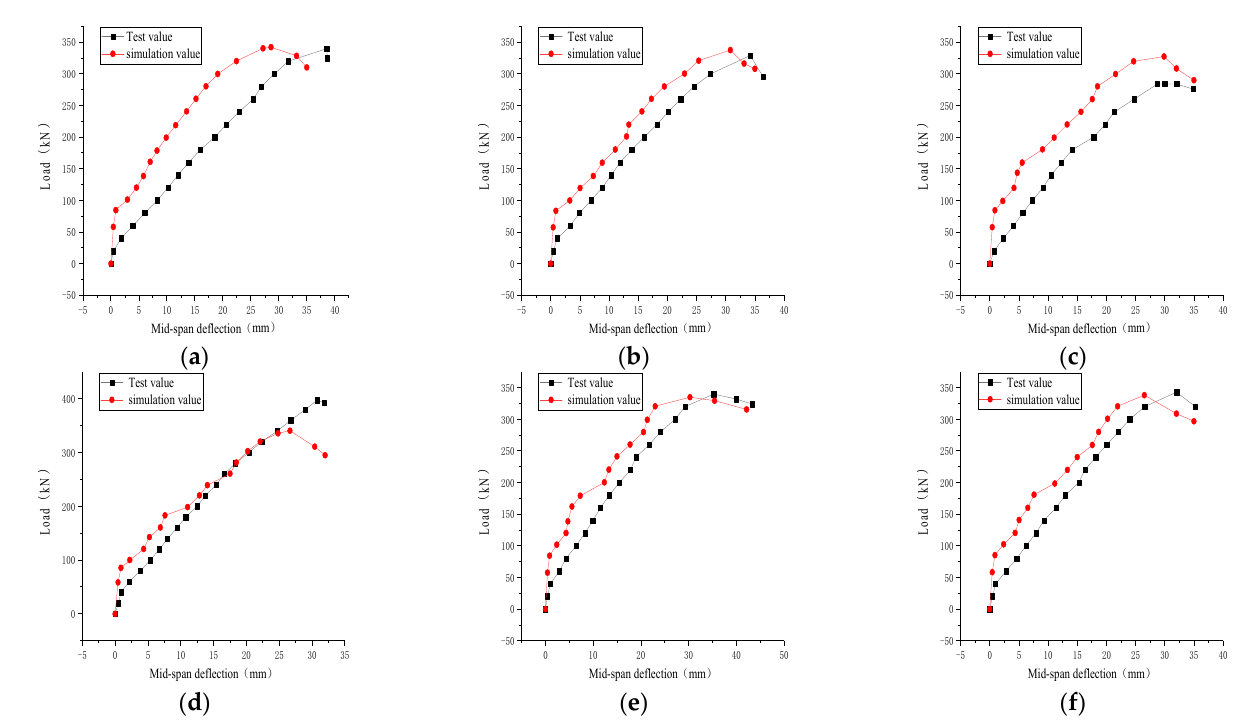
Figure 15. Comparison of load-deflection curves of test beam and simulated beam. ( a ) Beam L-0-0; Table 6. Simulation value and test value of the flexural ultimate bearing capacity.